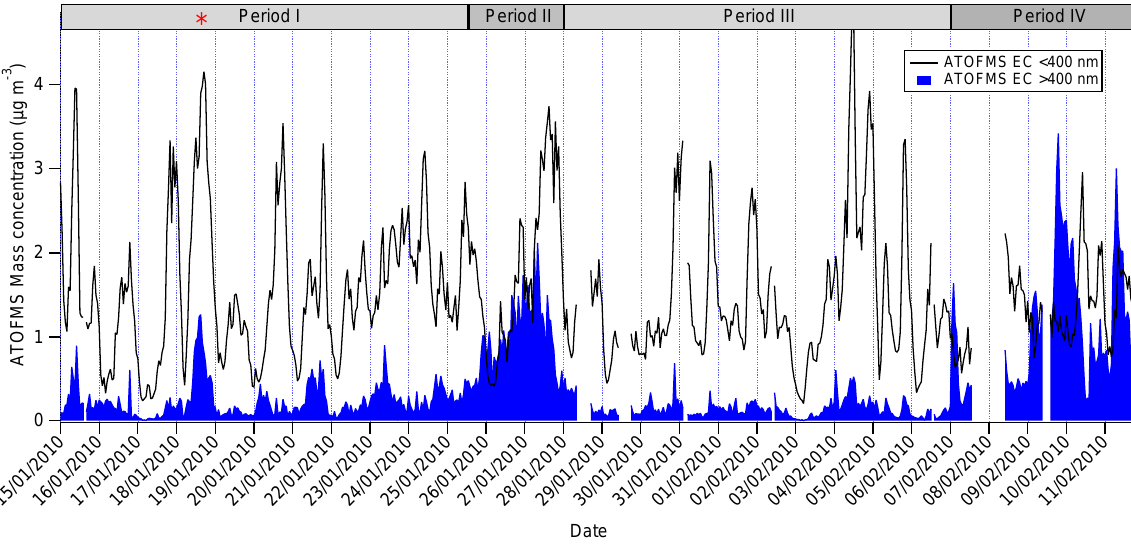
Fig. 9. Hourly total size-resolved ATOFMS scaled EC particle mass concentration. The minimum in the average bimodal EC particle mass size distribution at 400nm is represented by the red line.